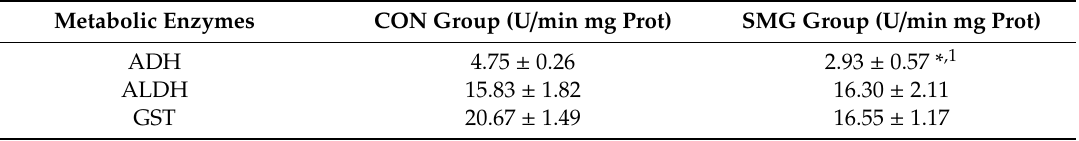
Table 3. Results of metabolic enzyme activity determination.